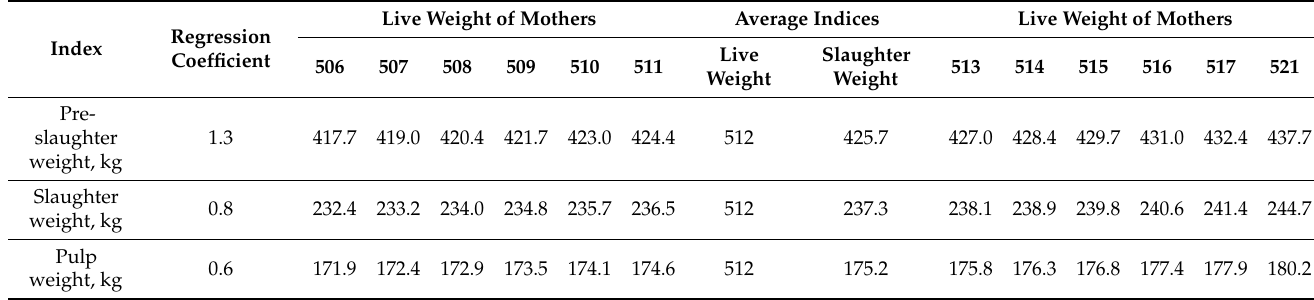
Table 3. Table for predicting the meat productivity of animals by the live weight of